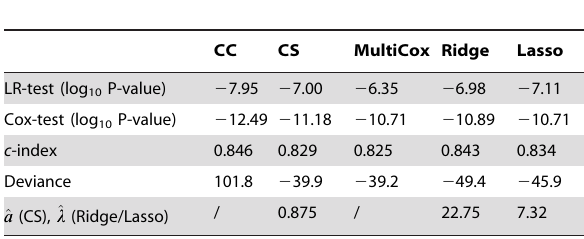
Table 3. Performance of the five methods based on the primary biliary cirrhosis of the liver